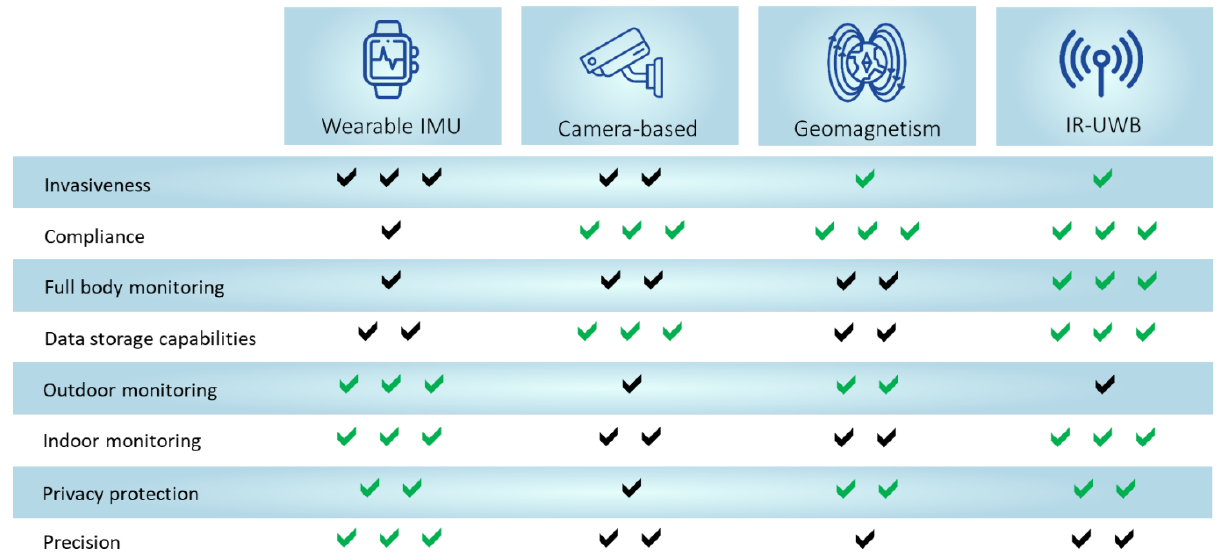
Figure 8. Qualitative features comparison between monitoring systems, in a scale from 1 ( low ) to 3 ( high ).